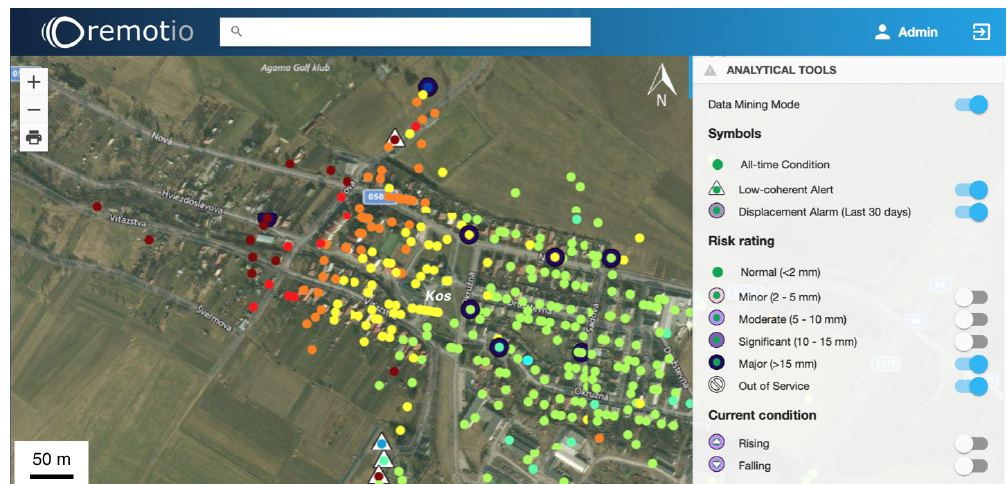
Figure 13. Mining subsidence in Kos: Analytical Tools and mean line-of-sight (LOS) velocities from Descending Track No. 51 shown in remotIO’s web